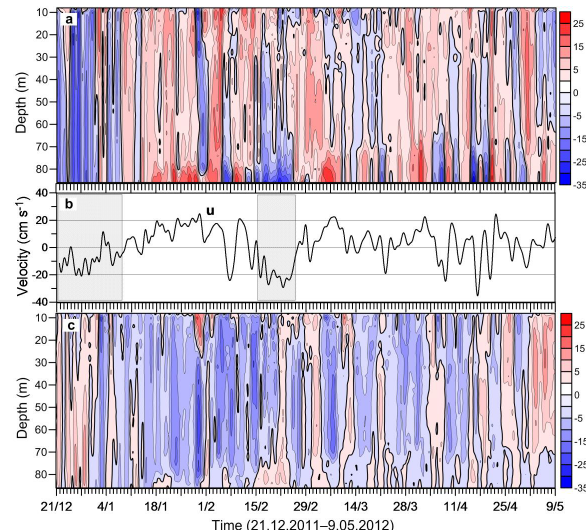
Figure 4. (a) Temporal progression of vertical distribution of low-pass filtered along-gulf axis current velocity component ( u ) and (c) cross-gulf axis current velocity component ( v ) in cm s –1 at the location of mooring station A3 from 21 December 2011 to 9 May 2012. Positive velocities (red) denote the inflow into the gulf or northward flow, and negative velocities (blue) denote the opposite, respectively. (b) Temporal course of along-gulf axis current velocity component ( u ) at the depth of 85 m. Shaded areas mark time intervals when estuarine circulation reversals were observed at location A3.